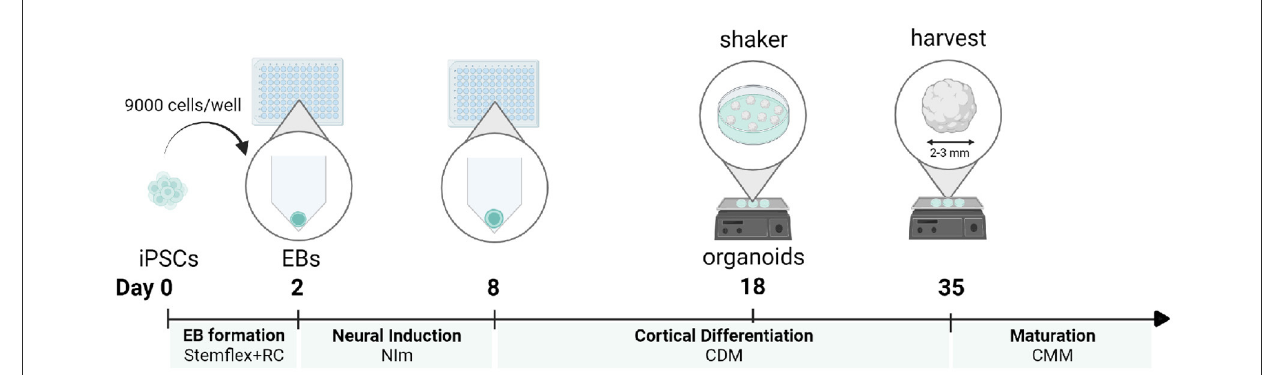
FIGURE1 Protocol timeline for a cortical organoid generation. For each developmental stage, the corresponding medium is displayed. iPSCs, induced pluripotent stem cells; EB, embryoid body; NI, neural induction; CDM, cortical differentiation medium; CMM, cortical maturation medium. This figure was created with